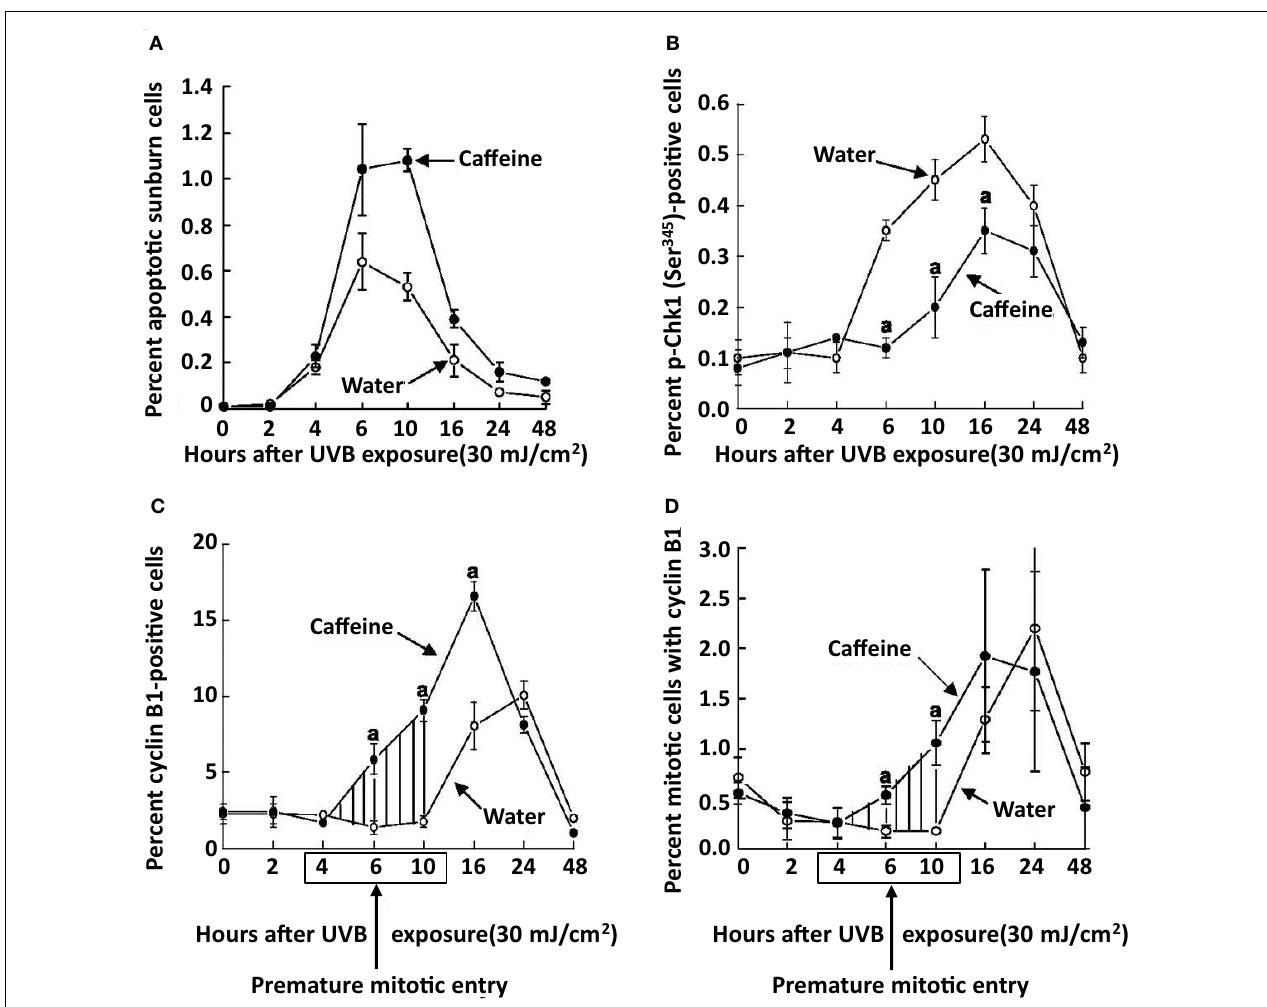
and killed at the indicated times.The percentage of phospho-Chk1 (Ser345) and cyclin B1-positive cells were determined immunohistochemically. Cells with both mitosis (measured by morphology) and cyclin B1 (measured by immunohistochemistry) were also determined. Points, mean of five mice; bars, SE. Shaded areas, premature mitotic entry by epidermal cells from caffeine-treated mice. a P < 0.01.Taken from Lu et al. (2008).